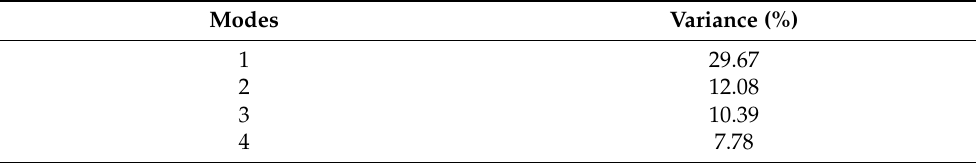
Table 3. Percentage of variance explained by the first four modes of variability of the terrestrial water storage (TWS) residuals. Before being analyzed with the PCA methodology, the TWS time series were detrended, deseasonalized, and finally